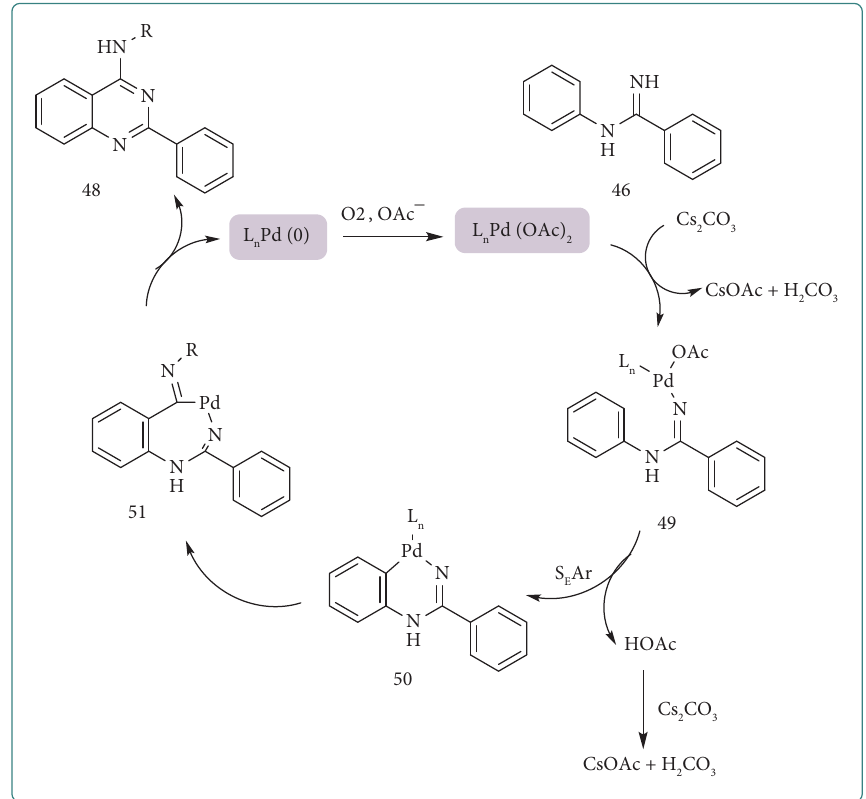
Figure 8: Te proposed mechanism for the synthesis of 4-amino-2-aryl(alkyl)quinazoline derivatives in the presence of Pd(OAc) and O 2